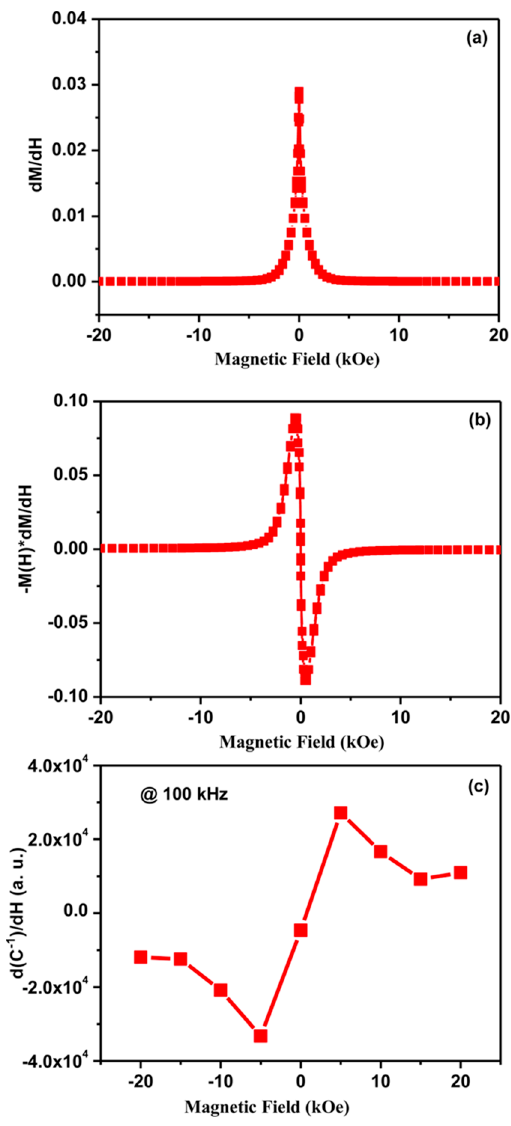
Figure 7. Magnetic field dependence of ( a ) dM / dH ( b ) M( dM / dH ), and ( c ) dC − 1 / dH of PC2 composite. Figure reproduced with permission from [22] .